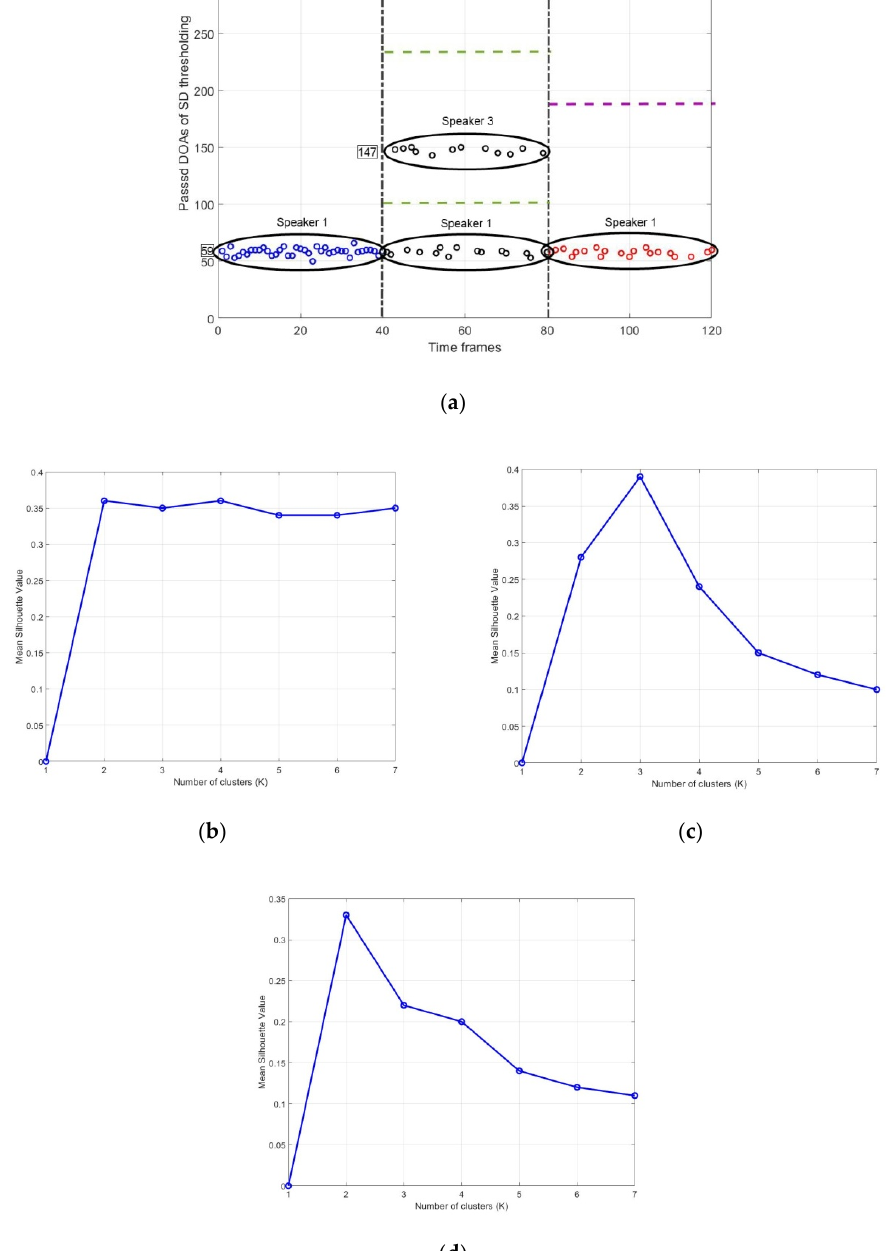
Figure 12. ( a ) The estimated DOAs with SBGEVD algorithm after thresholding on PDFs and means silhouette value (MSV) curve for ( b ) region 1(left), ( c ) region 2 (center) and ( d ) region 3 (right) in Figure